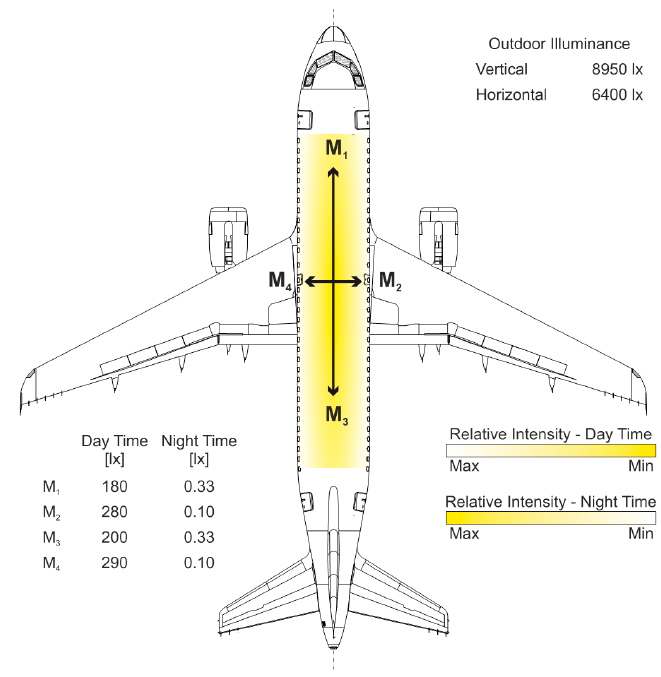
Figure 15. Results of measurement of illumination in the Airbus A-319CJ interior.